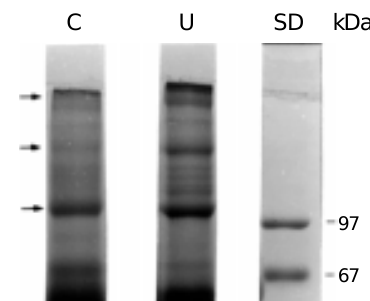
SD Figure 1 - SDS-PAGE profile of ECM pro-